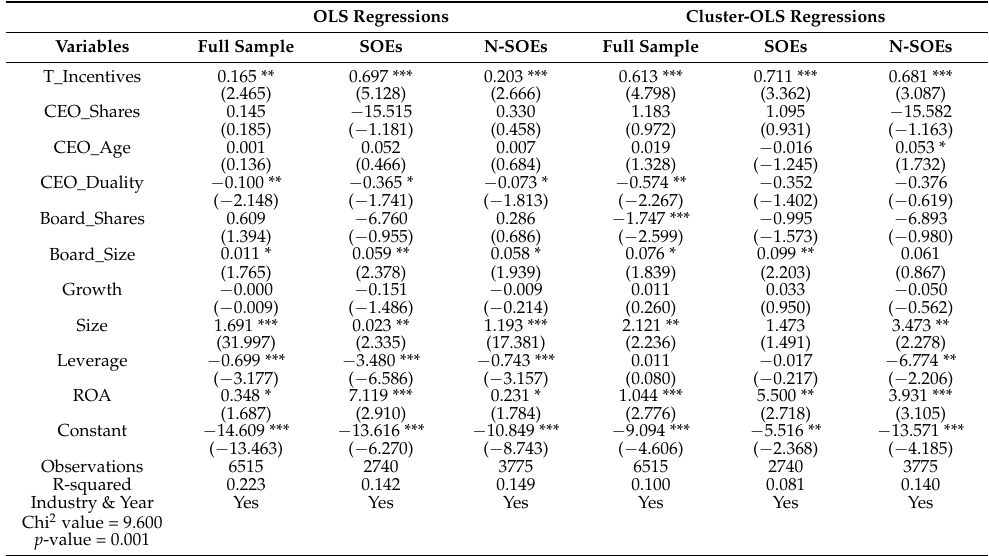
Table 4. Main evidence of CEOs tournament incentives and green